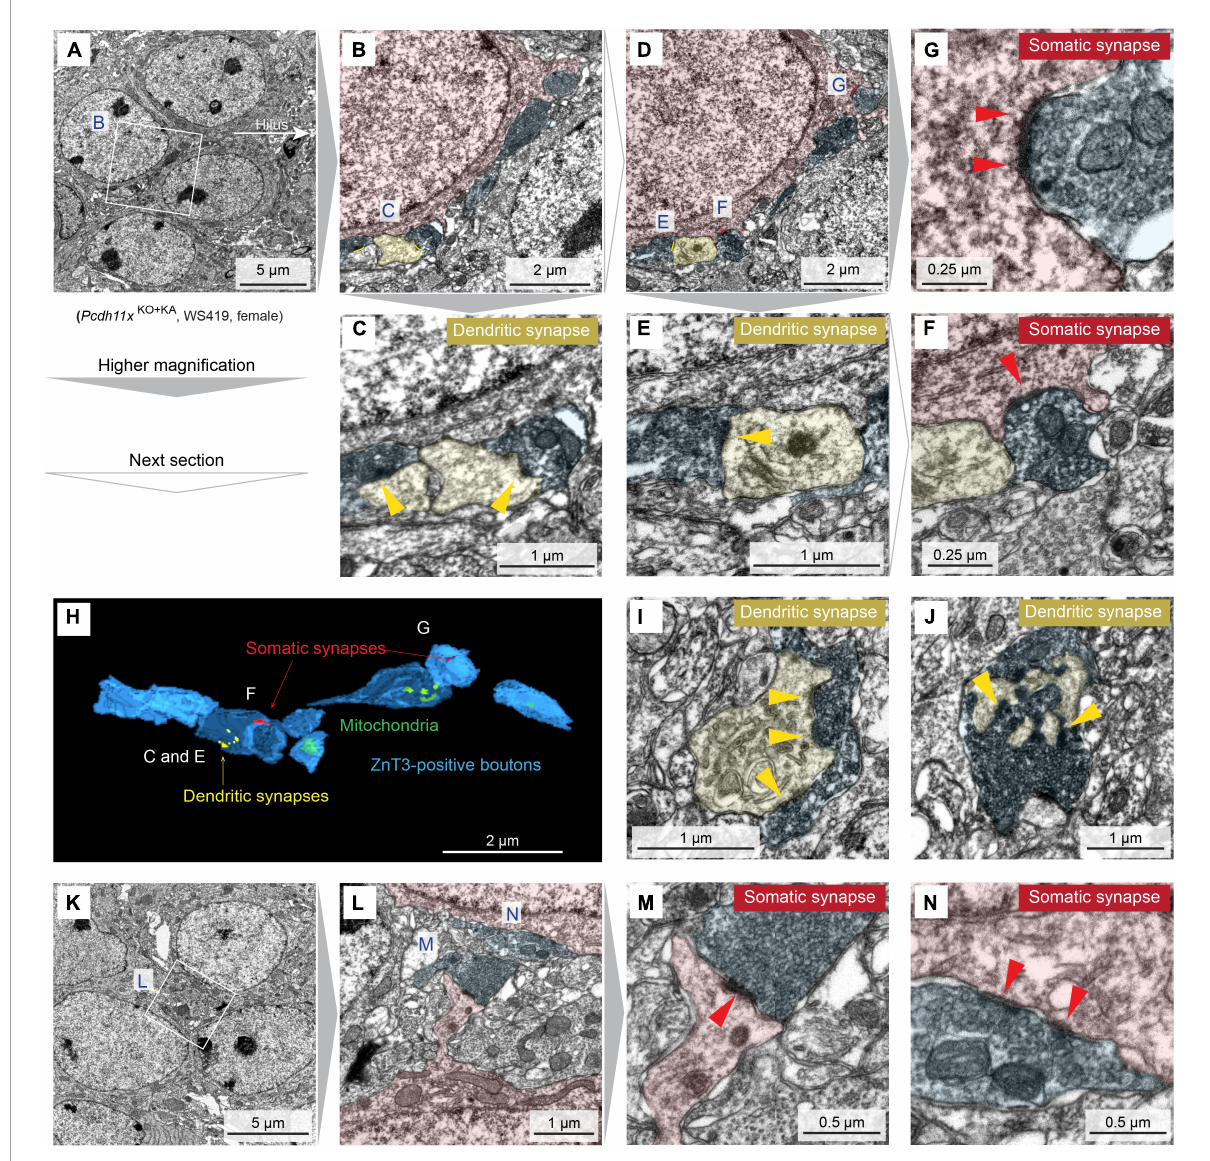
FIGURE7 Immuno-electron microscopy characterization of Pcdh11x KO + KA GC synapses. (A) Transmission electron microscopy image of four GC somata in GCL. In white box, ZnT3 + boutons are visible next to GC soma. (B) Magnification of the white box in panel A. GC soma, dendrite, and presynaptic ZnT3 + boutons are presudo-colored in red, yellow, and blue, respectively. (C) Magnification of the area labeled with C in panel B shows synapses on dendrites (yellow arrowheads). (D) Image shows the next section of what is shown in panel (B) . (E–G) Magnification of the areas labeled with E, G, and F in panel (D) show somatic, somatic and dendritic, and dendritic synapses, respectively (yellow and red arrowheads). In the lower right part of panel (F) , a dendritic synapse is also visible. However, the presynaptic compartment is lacking ZnT3 and thus MF identity of this synapse could not be confirmed. (H) 3D reconstruction of ZnT3 + boutons and synapses shown in panels (A–F) . (I,J) Images show additional dendritic synapses with multiple release sites (yellow arrowheads) from the same animal. (K) Image show five